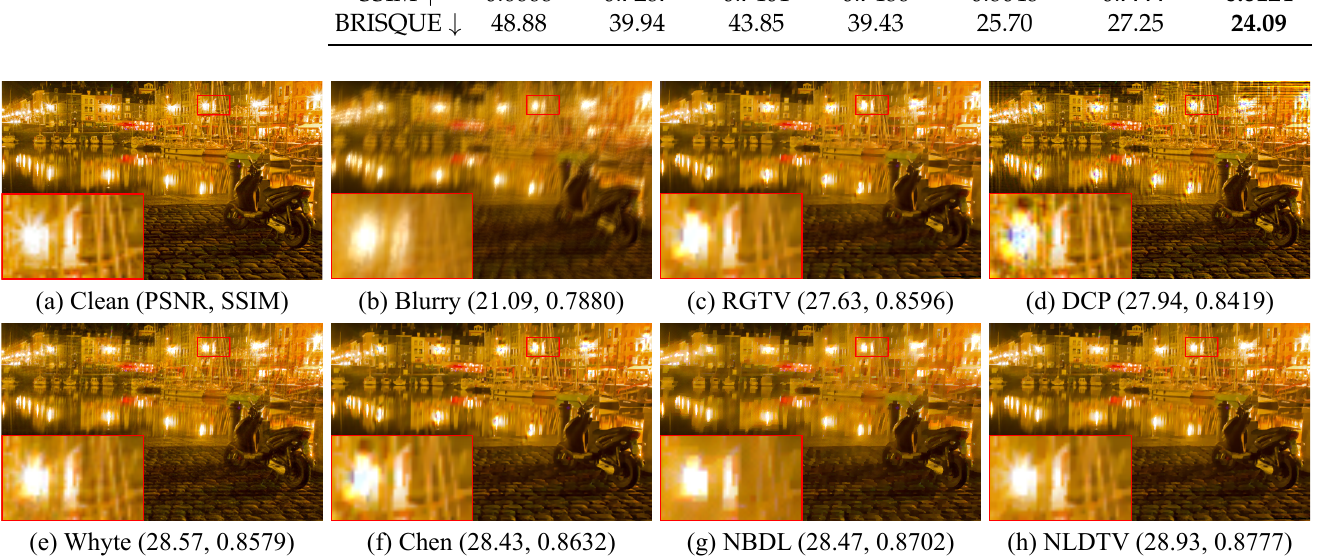
Figure 6. Qualitative evaluation on saturation dataset with motion blur. ( a ) Clean image, ( b ) blurry image, and ( c – h ) restored by RGTV [28], DCP [5], Whyte [14], Chen [19], NBDN [35], and the proposed